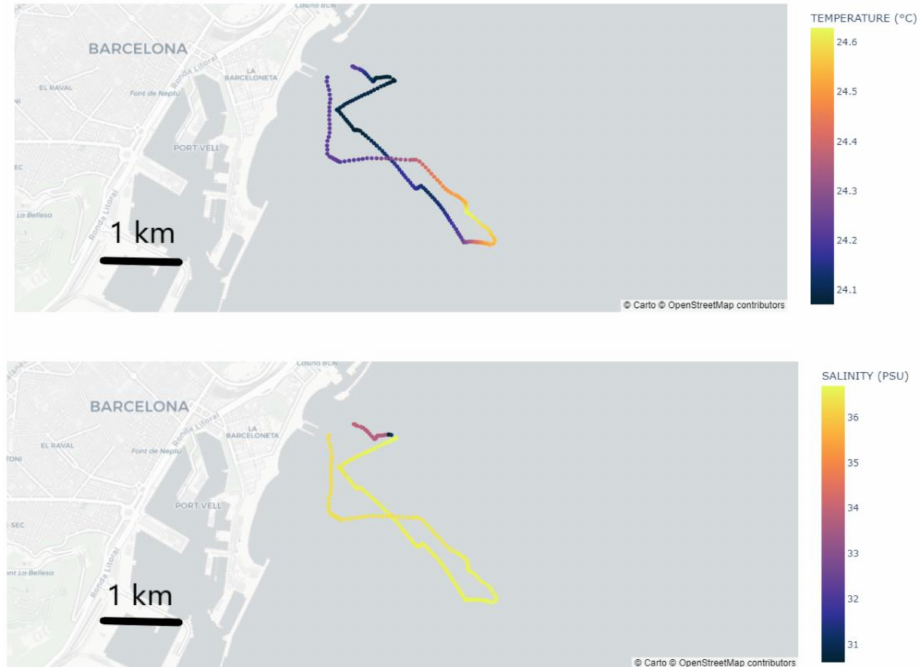
Figure 3. ( Top ) Sea-surface temperature and ( bottom ) sea-surface salinity on 22 July 2021, along the navigation track of the SPV.